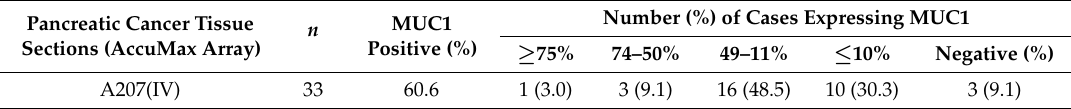
Table 1. Immunohistochemical analysis of MUC1 expression in pancreatic cancer tissues. Pancreatic Cancer Tissue Sections (AccuMax